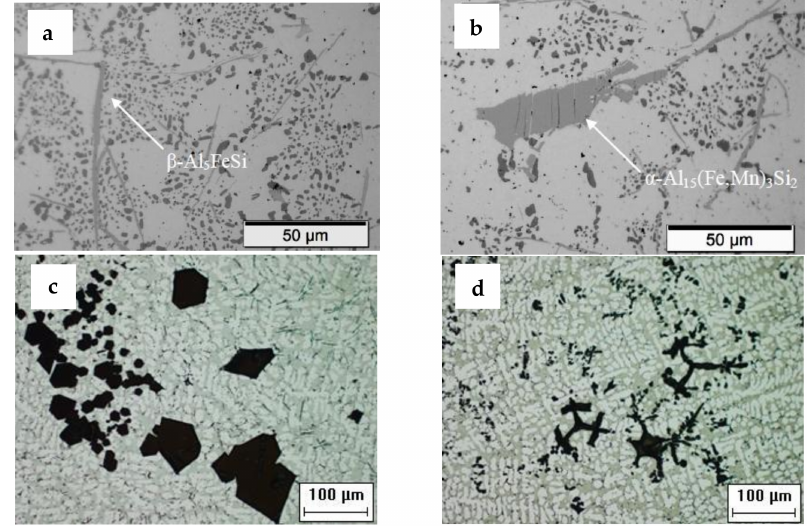
Figure 3. Optical images of intermetallic particles: ( a ) β -Fe phases; ( b ) α -Fe phase; ( c ) blocky-like and ( d ) star-like sludges; (a, b from